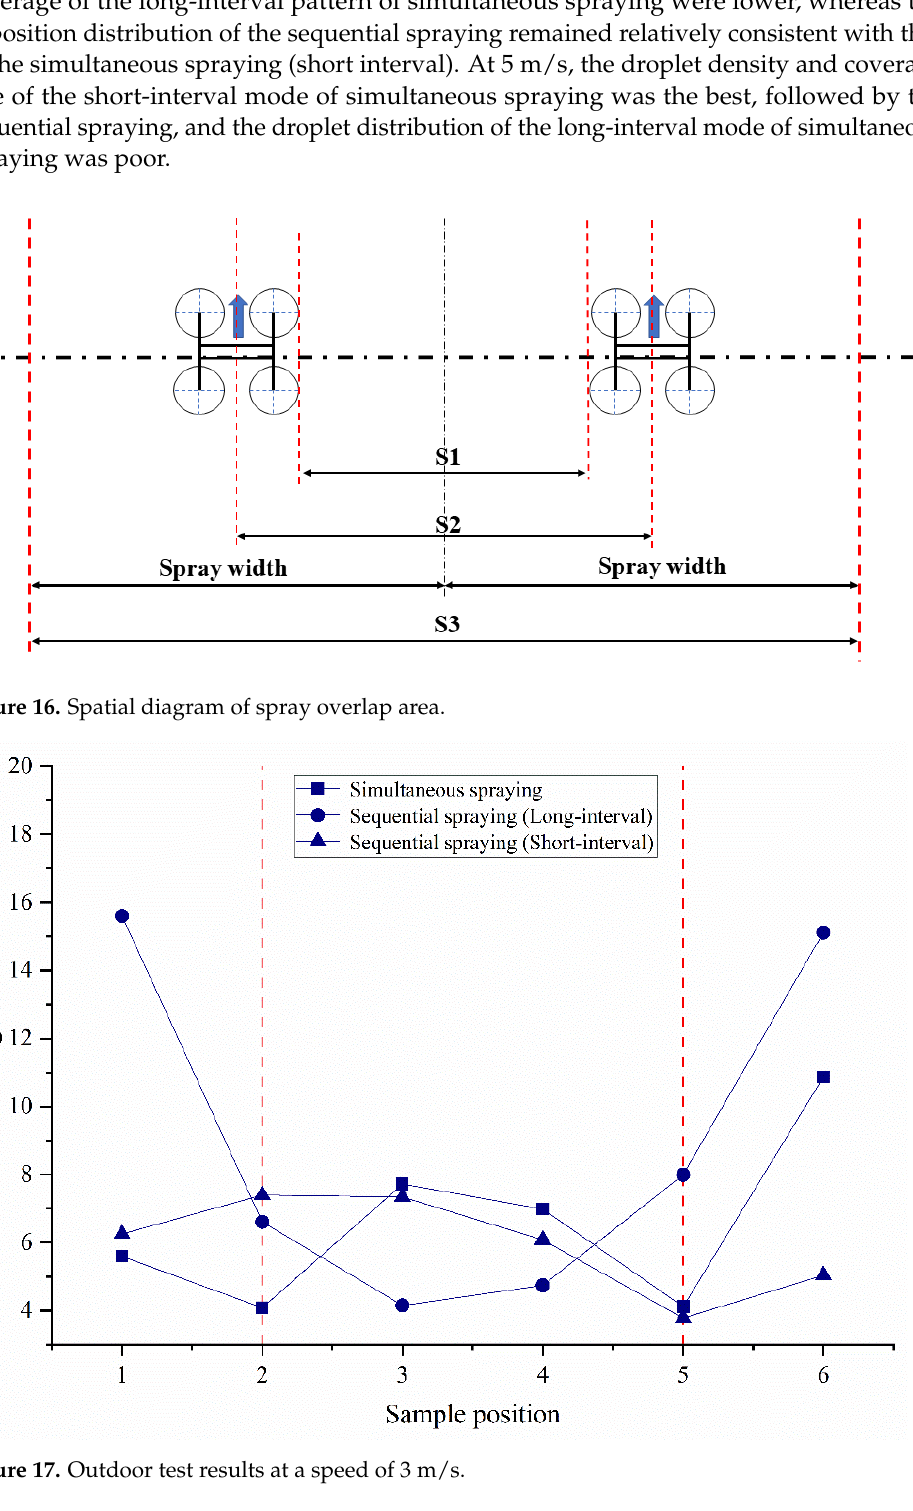
Figure 17. Outdoor test results at a speed of 3 m/s.